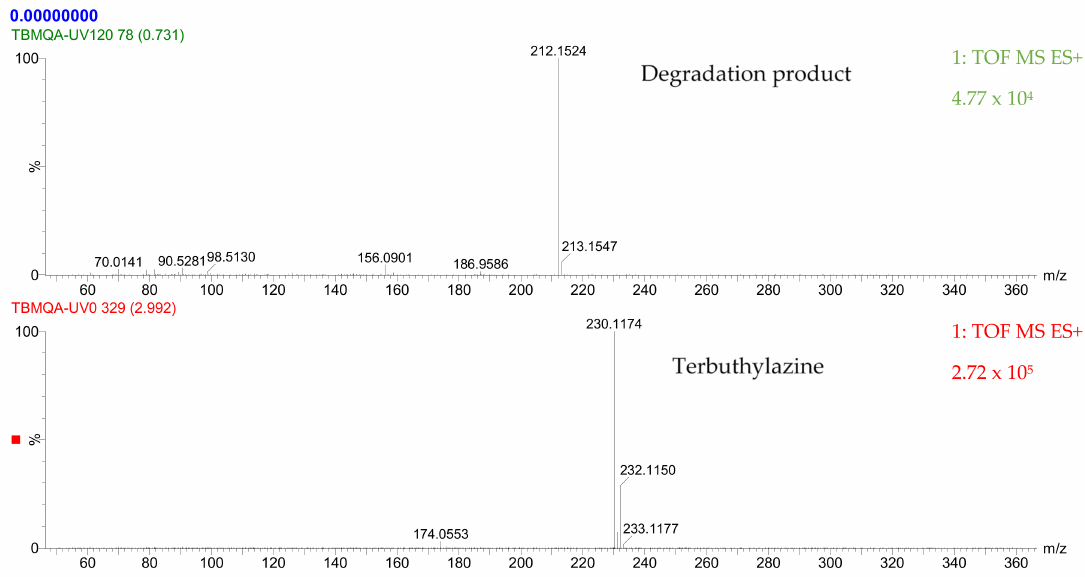
Figure 4. Mass chromatogram of terbuthylazine and its degradation products at time t = 0 and t = 120 s after UV irradiation in ultrapure water.